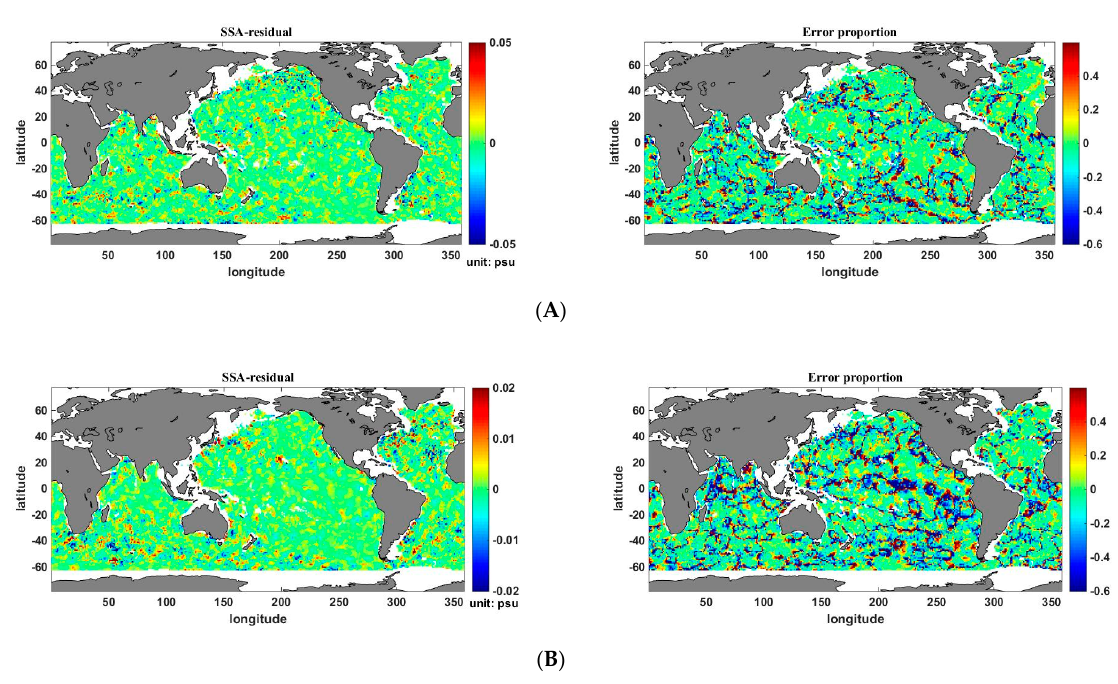
Figure 8. Spatial distribution of the STA errors (the first column) and the error proportion (the second column) retrieved using the XGBoost method in January 2015 at different depths: ( A ) 100 m, ( B ) 500 m, and ( C ) 1500 m.